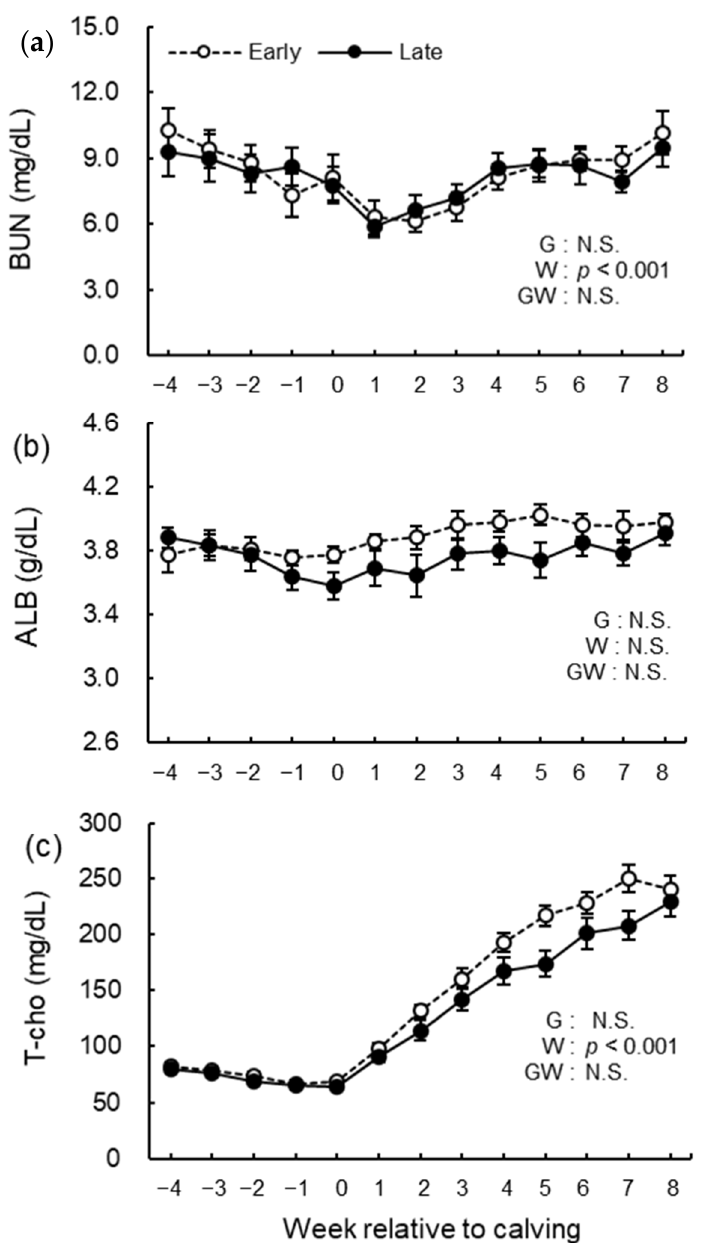
Figure 9. Serum concentrations of ( a ) blood urea nitrogen (BUN), ( b ) albumin (ALB), and ( c ) total cholesterol (T-cho) from −4 to 8 wk relative to calving for cows classified into the early group (Early) and the late group (Late). Early = cows with endometrial inflammation converged within 4 wk, n = 17; Late = cows with endometrial inflammation converged at or after 5 wk, n = 16. The week of calving is defined as 0 wk. G = group effect; W = week effect; GW = group-by-week interaction. Data are shown as mean ± SEM.